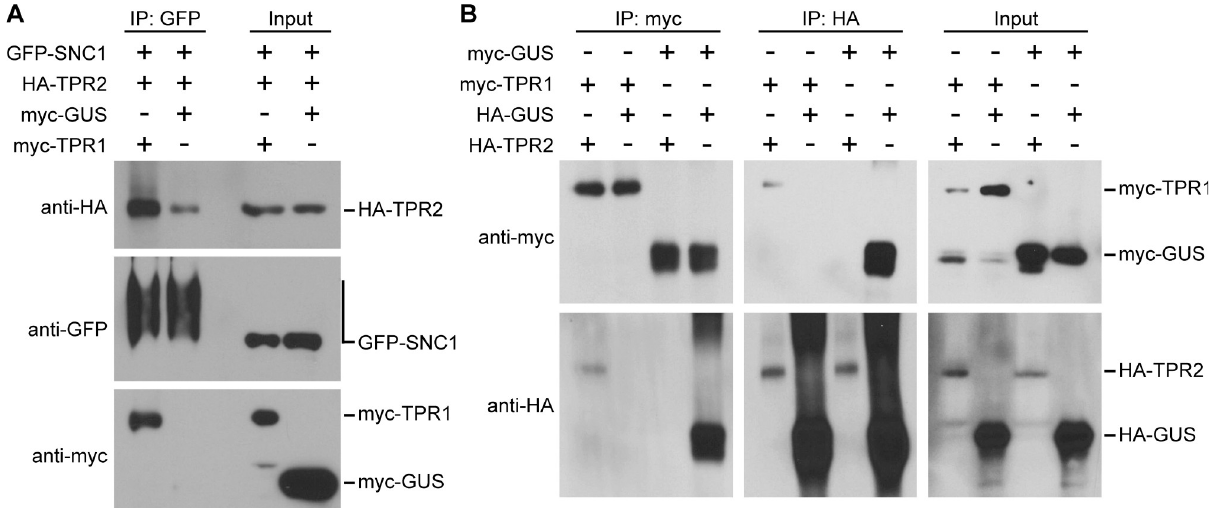
Fig 9. SNC1, TPR1 and TPR2 interact with each other in vivo . Tagged proteins were expressed in N . benthamiana eds1-1 plants. (A) Immunoprecipitation of GFP-SNC1 and detection of co-immunoprecipitated myc-TPR1, and of HA-TPR2 in the presence or absence of myc-TPR1, with myc-GUS as a control. (B) Reciprocal co-immunoprecipitation of myc-TPR1 and HA-TPR2, with correspondingly tagged GUS as negative (interaction with TPR) and positive (self-interaction) control. The expected protein band positions based on molecular size markers are indicated to the right of